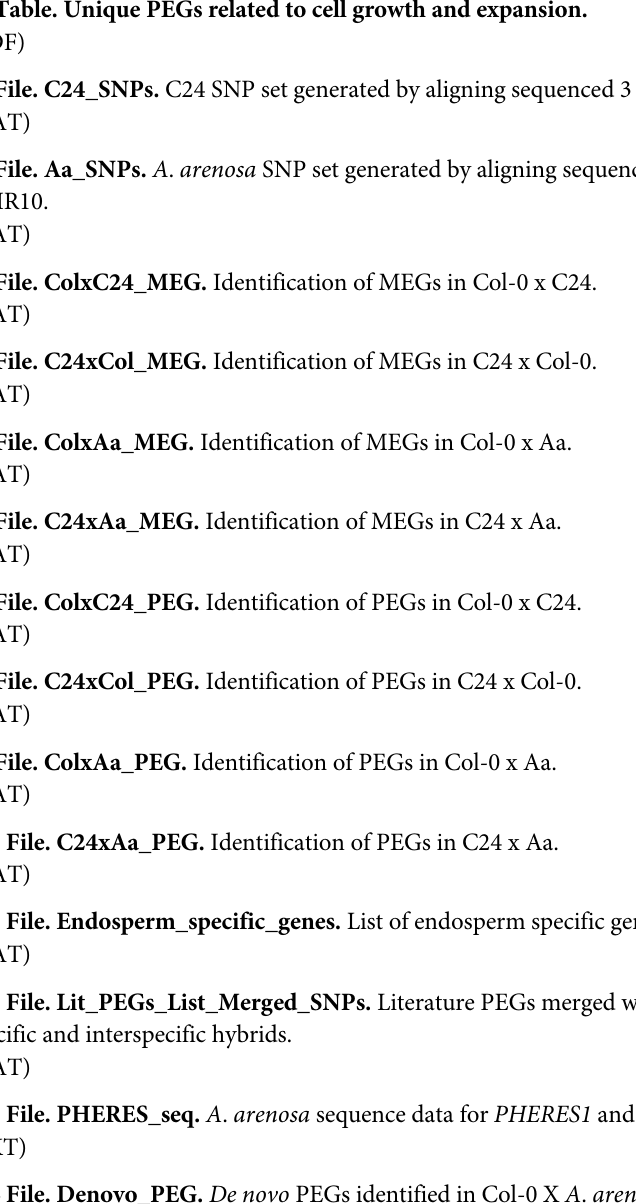
S5 Table. Unique PEGs related to cell growth and